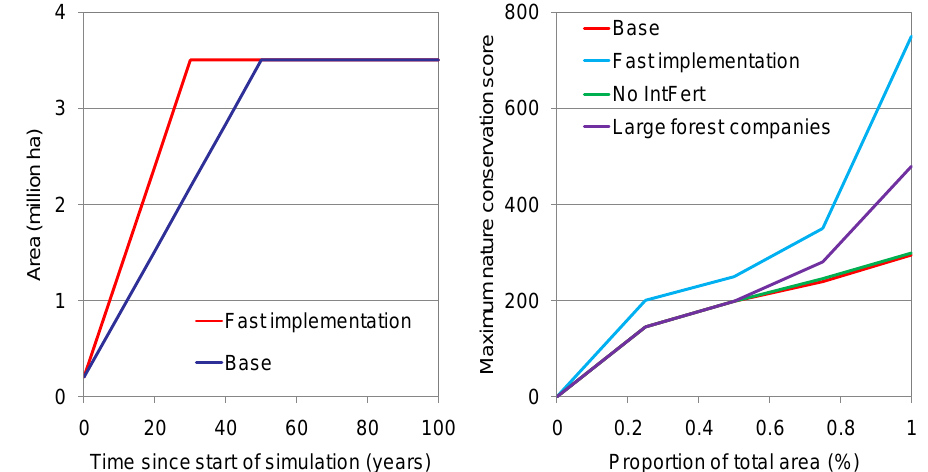
Figure 2. Accumulation over time of the area used for IFM in the ―Base‖ and ―Fast implementation‖ scenarios (left) and maximum nature conservation score (NCS) per quartile of the area sorted by NCS for each scenario